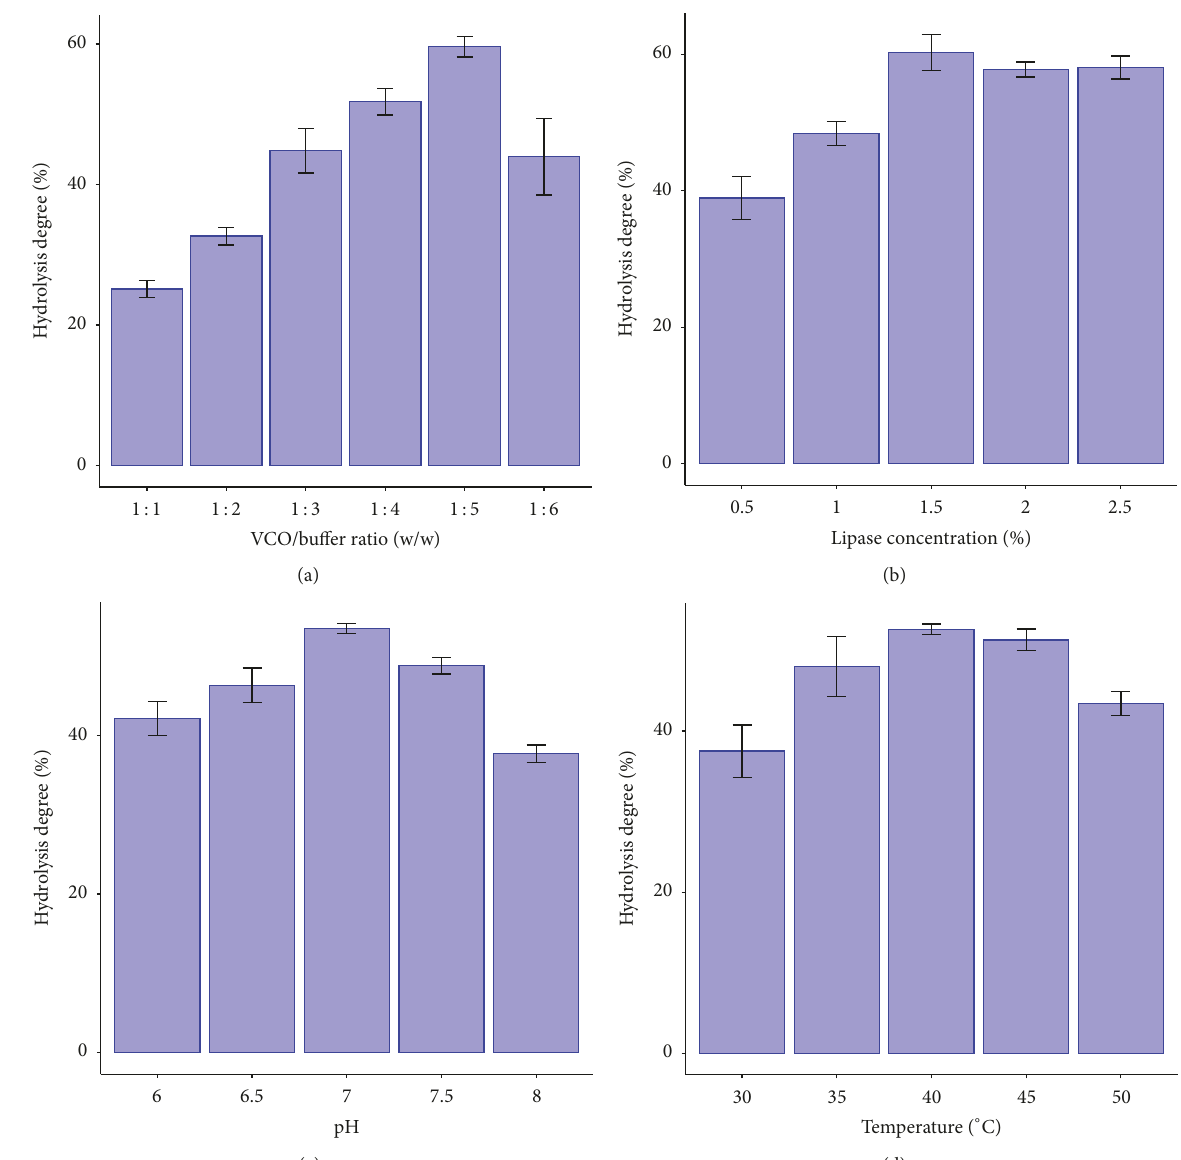
Figure 1: The rate of VCO to buffer (a), CRL concentration (b), pH (c), and temperature (d) effect on hydrolysis degree of VCO by CRL.